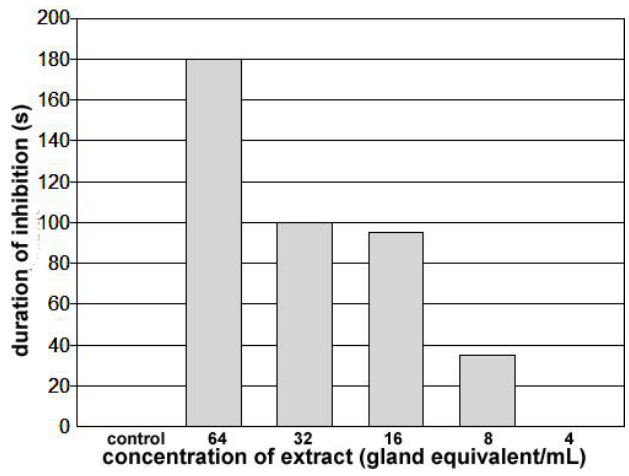
Figure 8. Duration of inhibition of the heartbeat for spermatophore extracts applied to a heart beating spontaneously at approximately 5 bpm for at least 10 minutes. Application of a 25 (cid:177) 50 µL of control saline increased heart rate for approximately 30 s and application of less than 8 gland equivalents/mL did not slow the heartbeat. Application of concentrations of 8 or higher increased the duration of inhibition progressively. At 64 glands equivalents/mL, the heart remained quiet for greater than 3